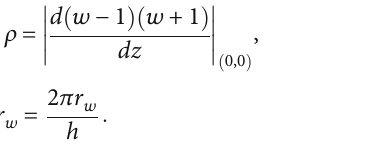
Figure 1: Schematic diagram of a horizontal well in top-bottom closed boundary